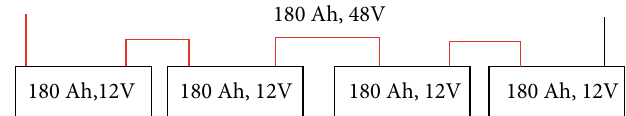
Figure 22: Battery con fi guration house 5.